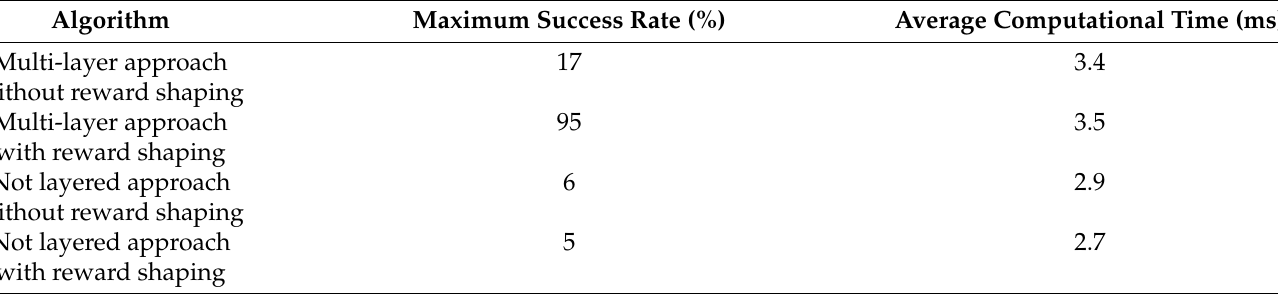
Table 4. Simulation results of algorithm without considering arrival